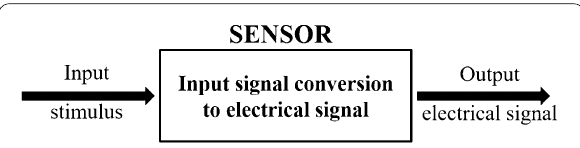
Fig. 1 Basic structure of a generic sensor consisting of the conversion circuitry that transforms the input energy to electrical